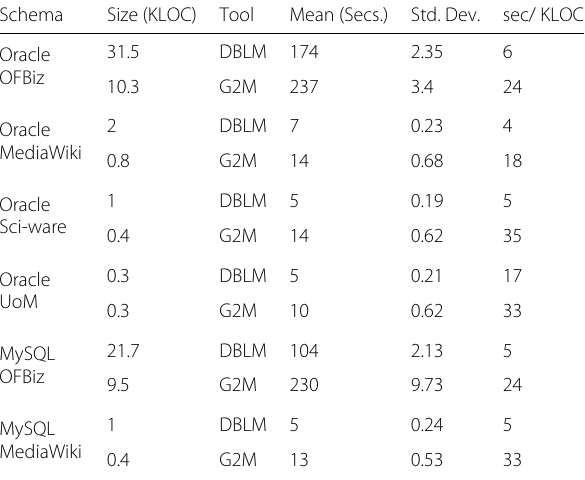
Table 3 Model extraction times using DBLModeller and Gra2MoL